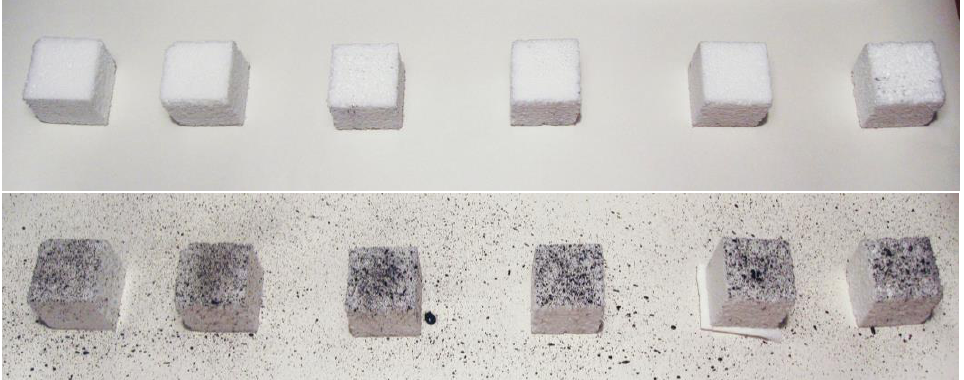
Fig. 1. Sample Preparation: before and after the painting of a stocastical